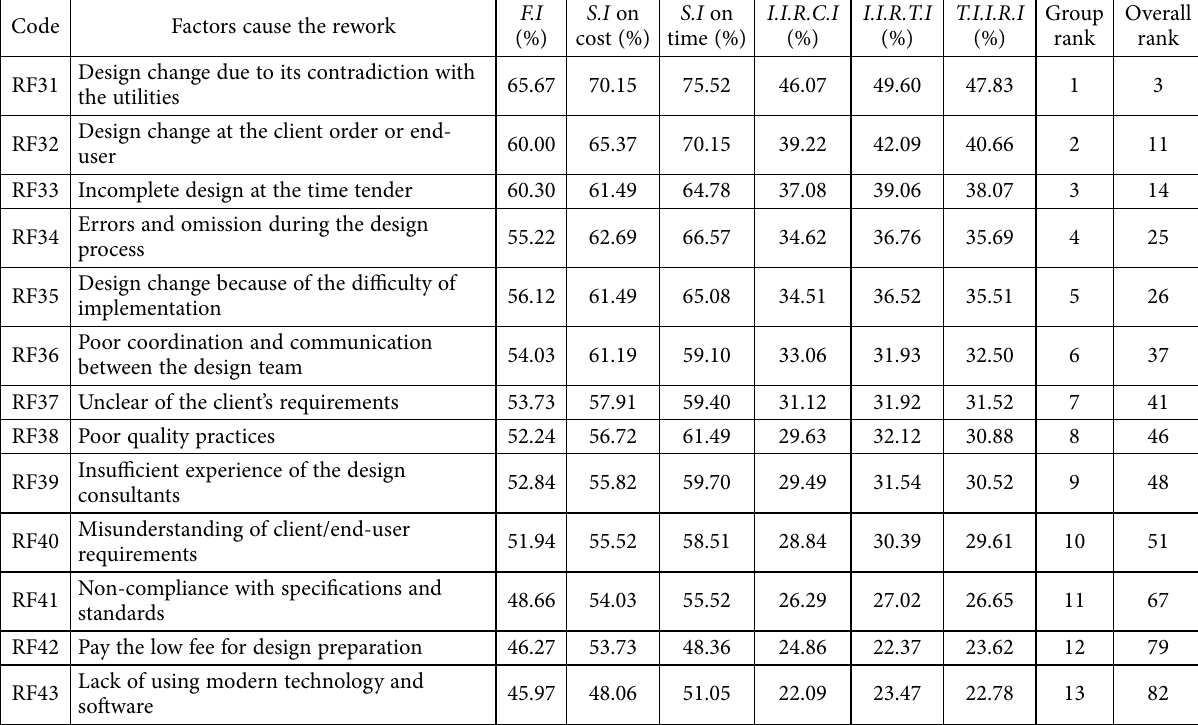
Table 7. Ranking the causes and impact of rework factors related to the design group